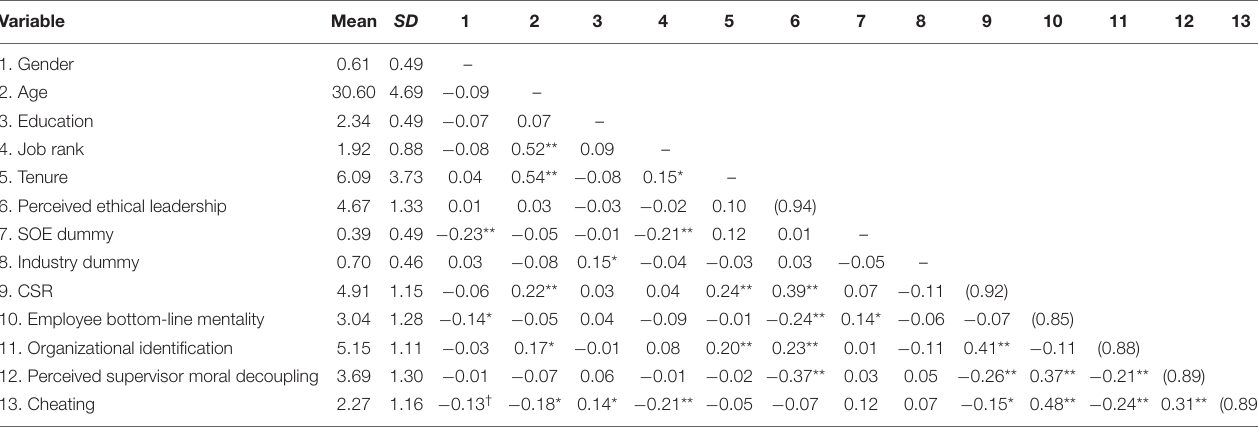
TABLE 2 | Descriptive statistics and correlation matrix.